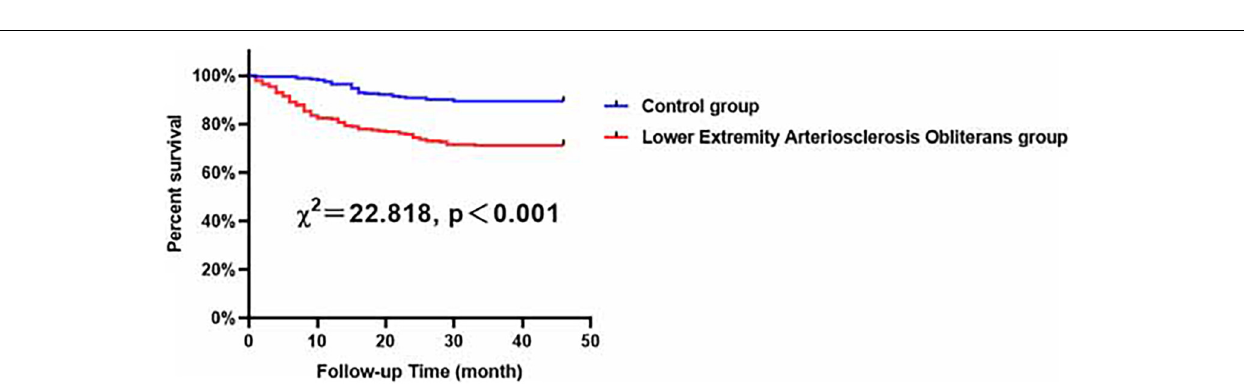
FIGURE 2 | Receiver operating character analysis for the predictive efficacy of variables for MACCEs (Model 1, Gender + Age + Hypertension + Diabetes + current smoking + current drinking; Model 2, Model 1 + LEASO).